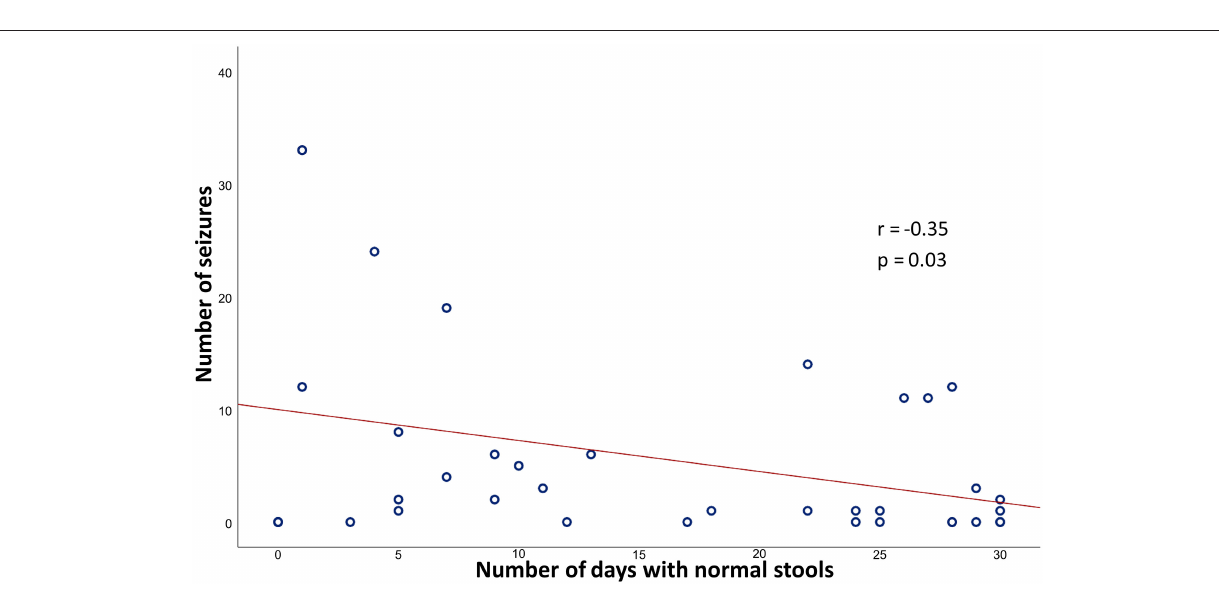
FIGURE 2 | Pearson correlation coefficient ( r ) and p -value ( p ) between the number of seizures/month and the number of days with normal stools/month. The graph shows a significant negative correlation between the number of seizures/month and the number of days with normal